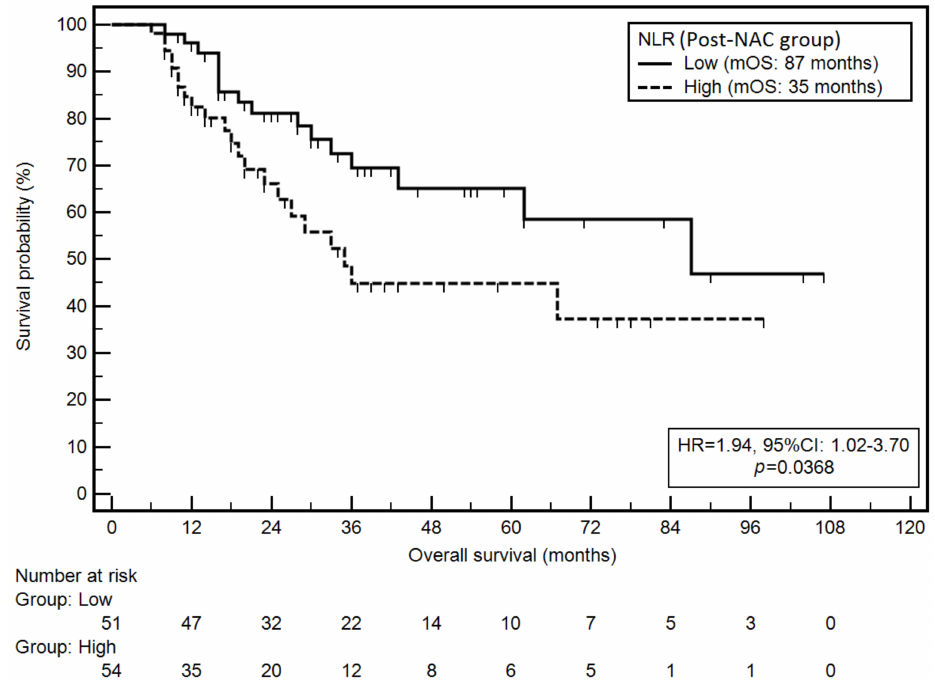
Figure 4. Kaplan–Meier graph representing survival probability in relation to the NLR (post- NAC